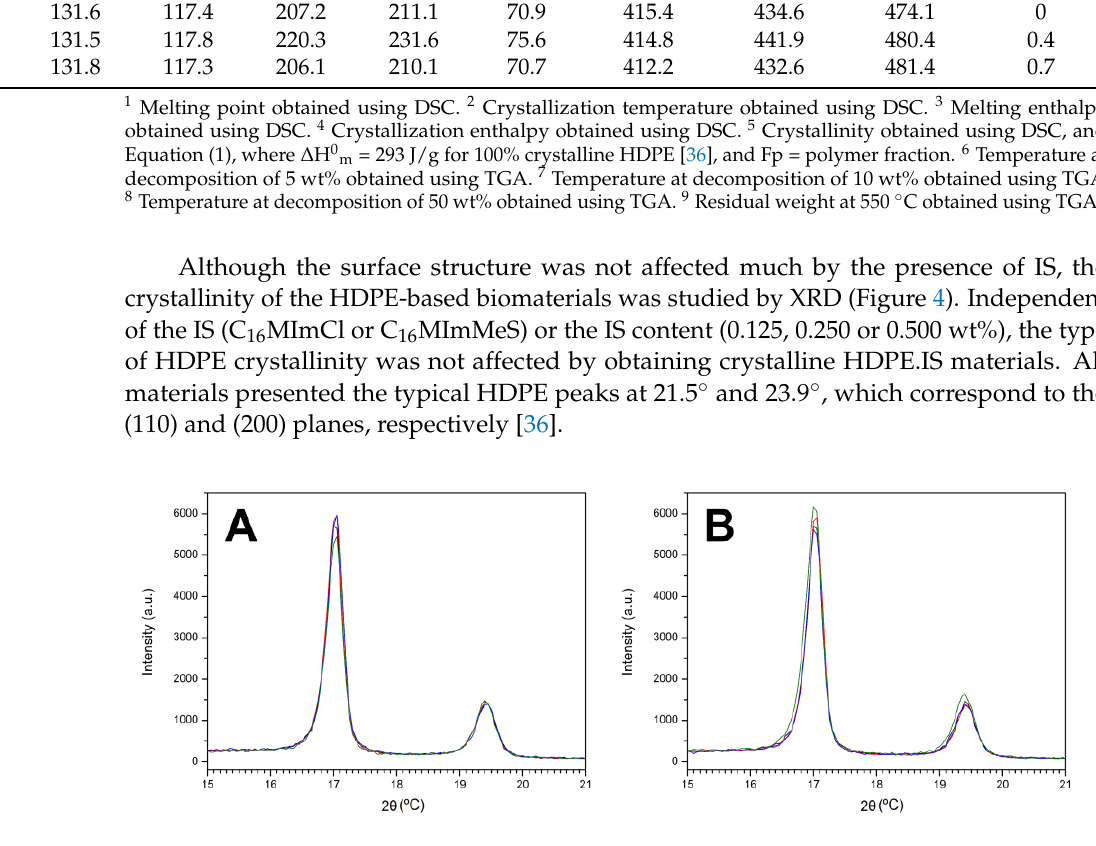
Figure 4. XRD diffractograms (a.u. = arbitrary units) within the 2θ range of ( A ) 15 – 25°, HDPE (black line), HDPE.Cl.0125 (red line), HDPE.Cl.0250 (blue line), and HDPE.Cl.0500 (green line) and ( B ) HDPE (black line), HDPE.MeS.0125 (red line), HDPE.MeS.0250 (blue line), and HDPE.MeS.0500 (green line).